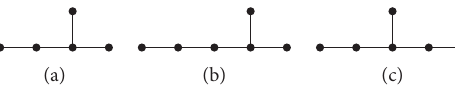
Figure 2: The trees (a) T1, (b) T